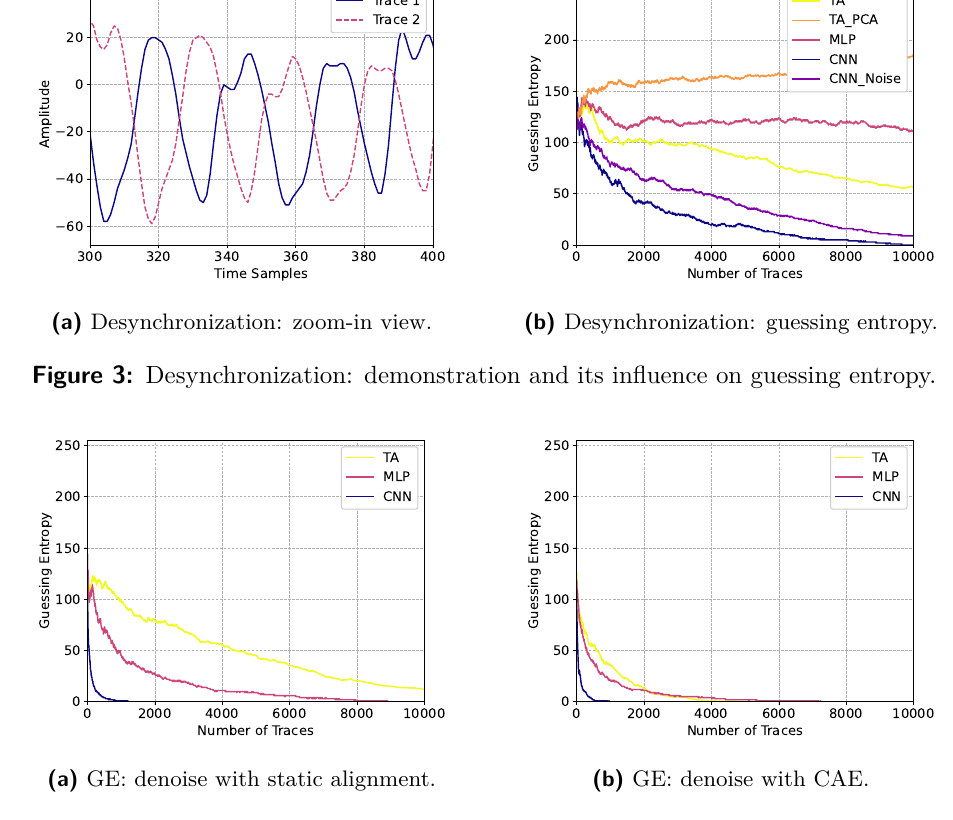
Figure 4: Guessing entropy: denoising desynchronization with static alignment (a) and CAE